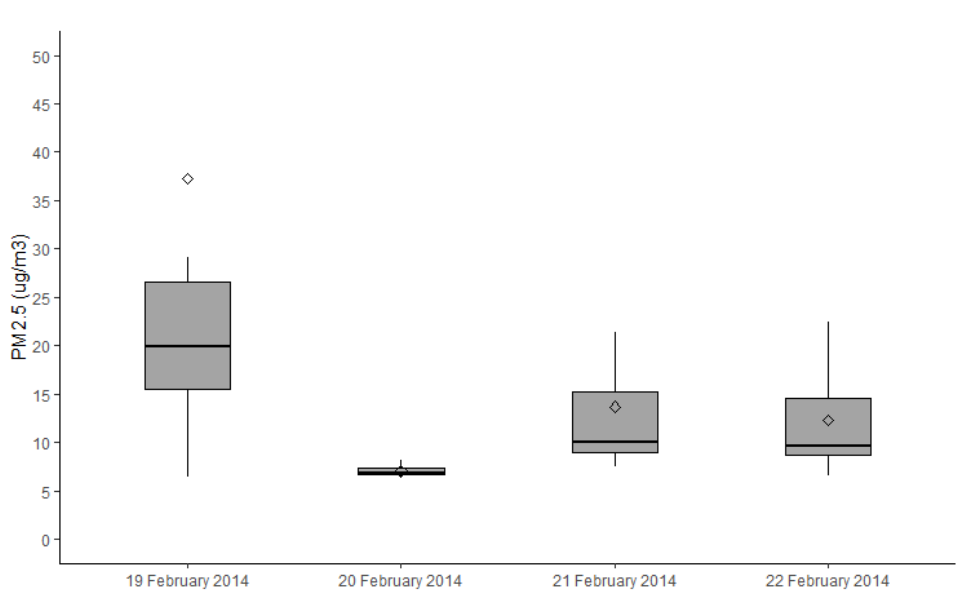
Figure 4. Boxplots showing median, quartiles and extreme concentrations of PM 2.5 (µg/m 3 ) as measured on the day’s health assessments were conducted in Traralgon. Note that the coal mine fire only impacted Traralgon during the study.